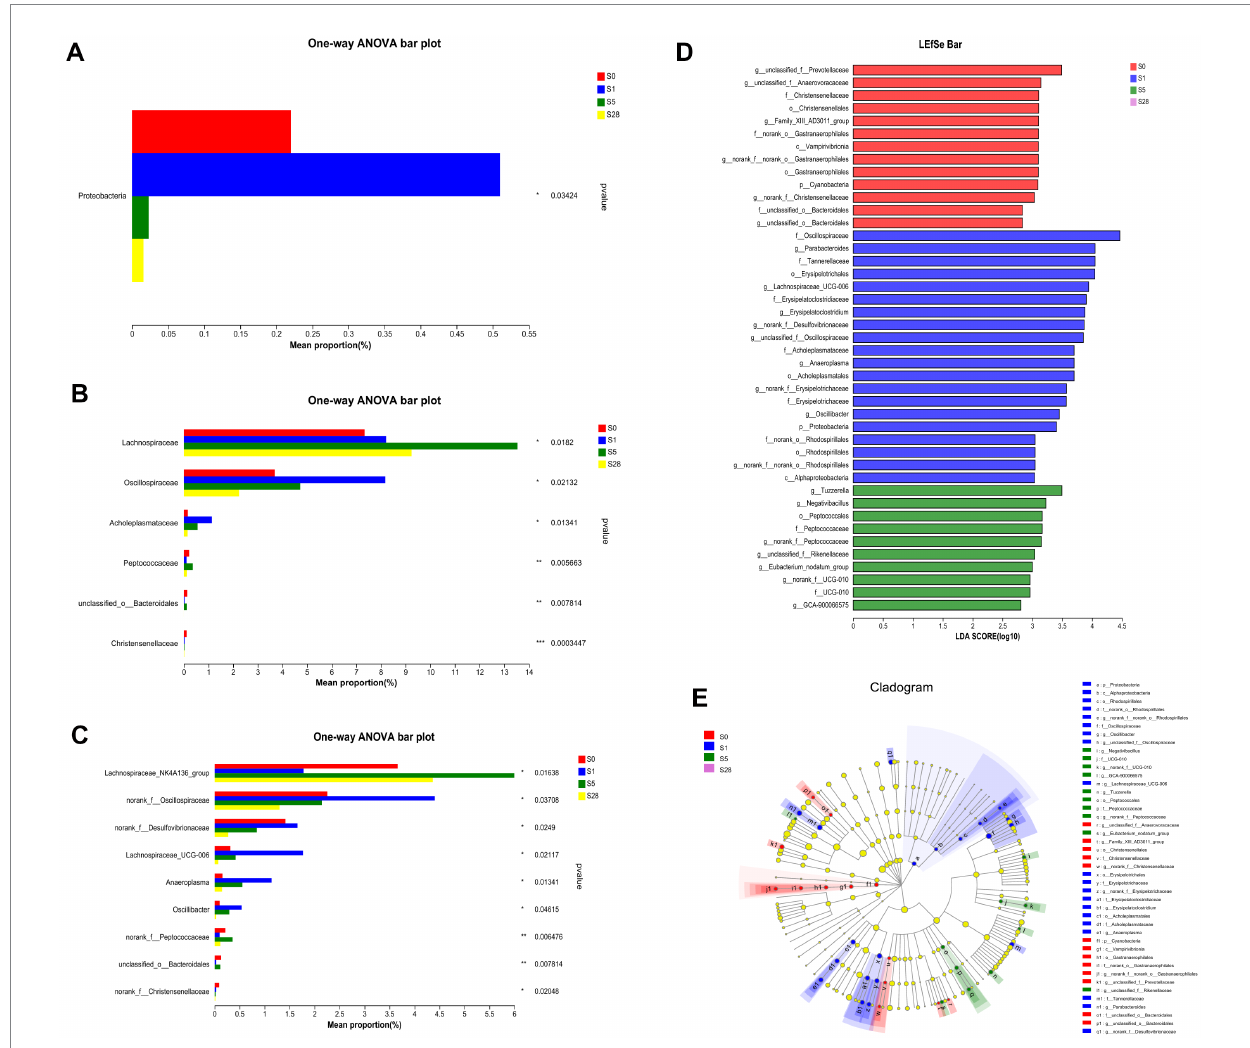
FIGURE 4 Further analysis on the day before burn injury and the days 1, 5, 28 after burn. Significance test of differential bacteria at the phylum level (A) , family level (B) , and genus level (C) , using one-way ANOVA, * p < 0.05, ** p < 0.01, *** p < 0.001. The length of bar represents the abundance of bacteria.